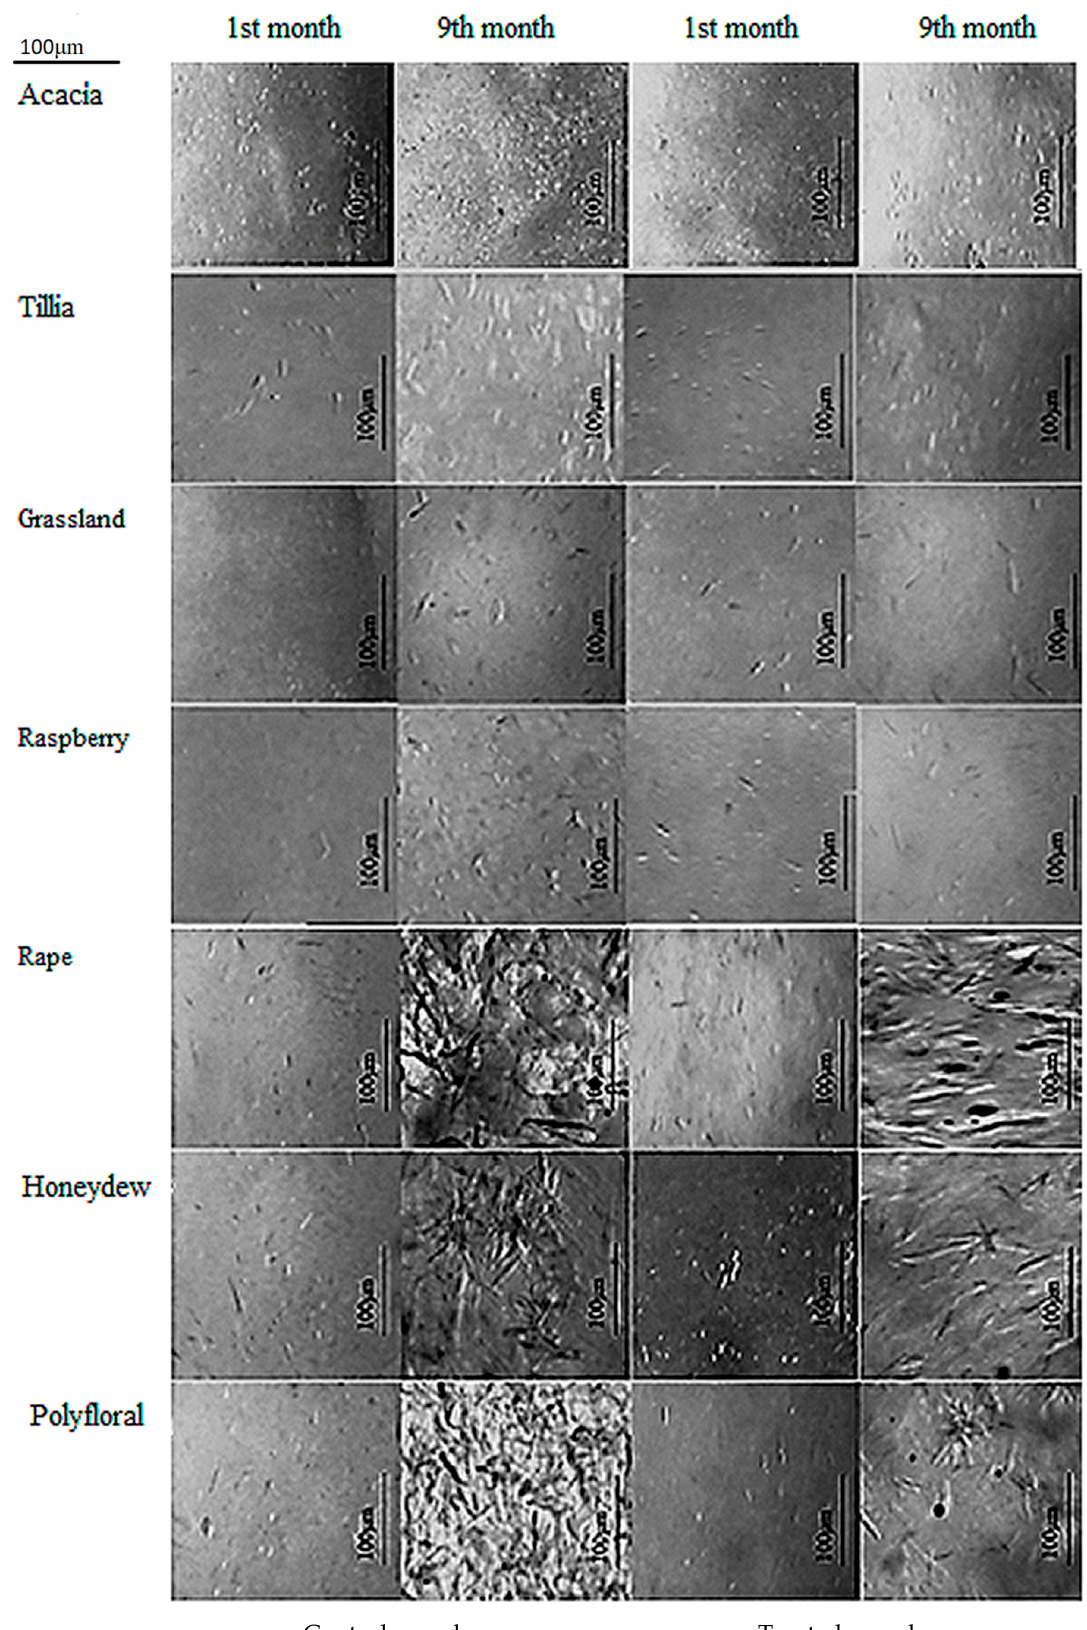
Figure 3. Microscopic images of the crystals of the seven types of honey analyzed.